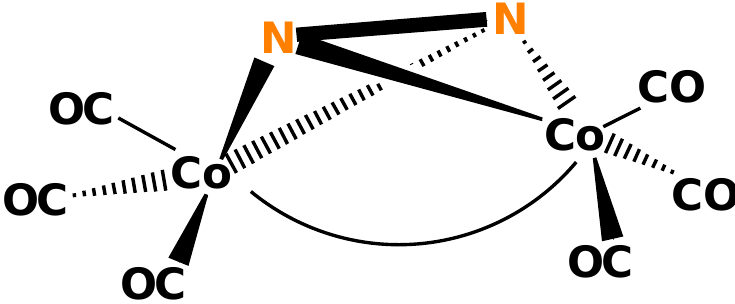
Figure 7. Schematic view of the structure of hypothetic (μ 2 -N 2 )Co 2 (CO) 6 ( Co–Co ) [35,36].